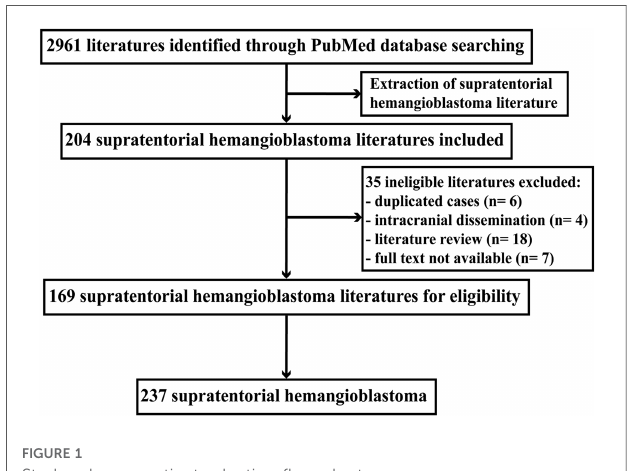
FIGURE 1 Study schema: patient selection fl ow chart.